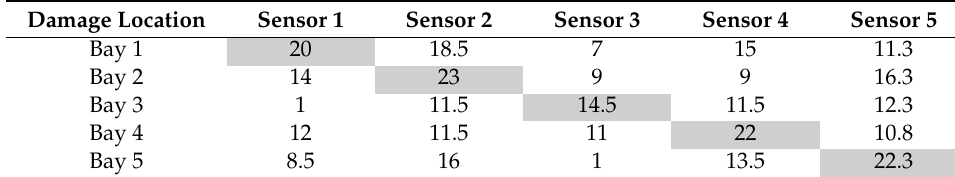
Table 4. Detectability in decibels for the IC damage analysis (DV